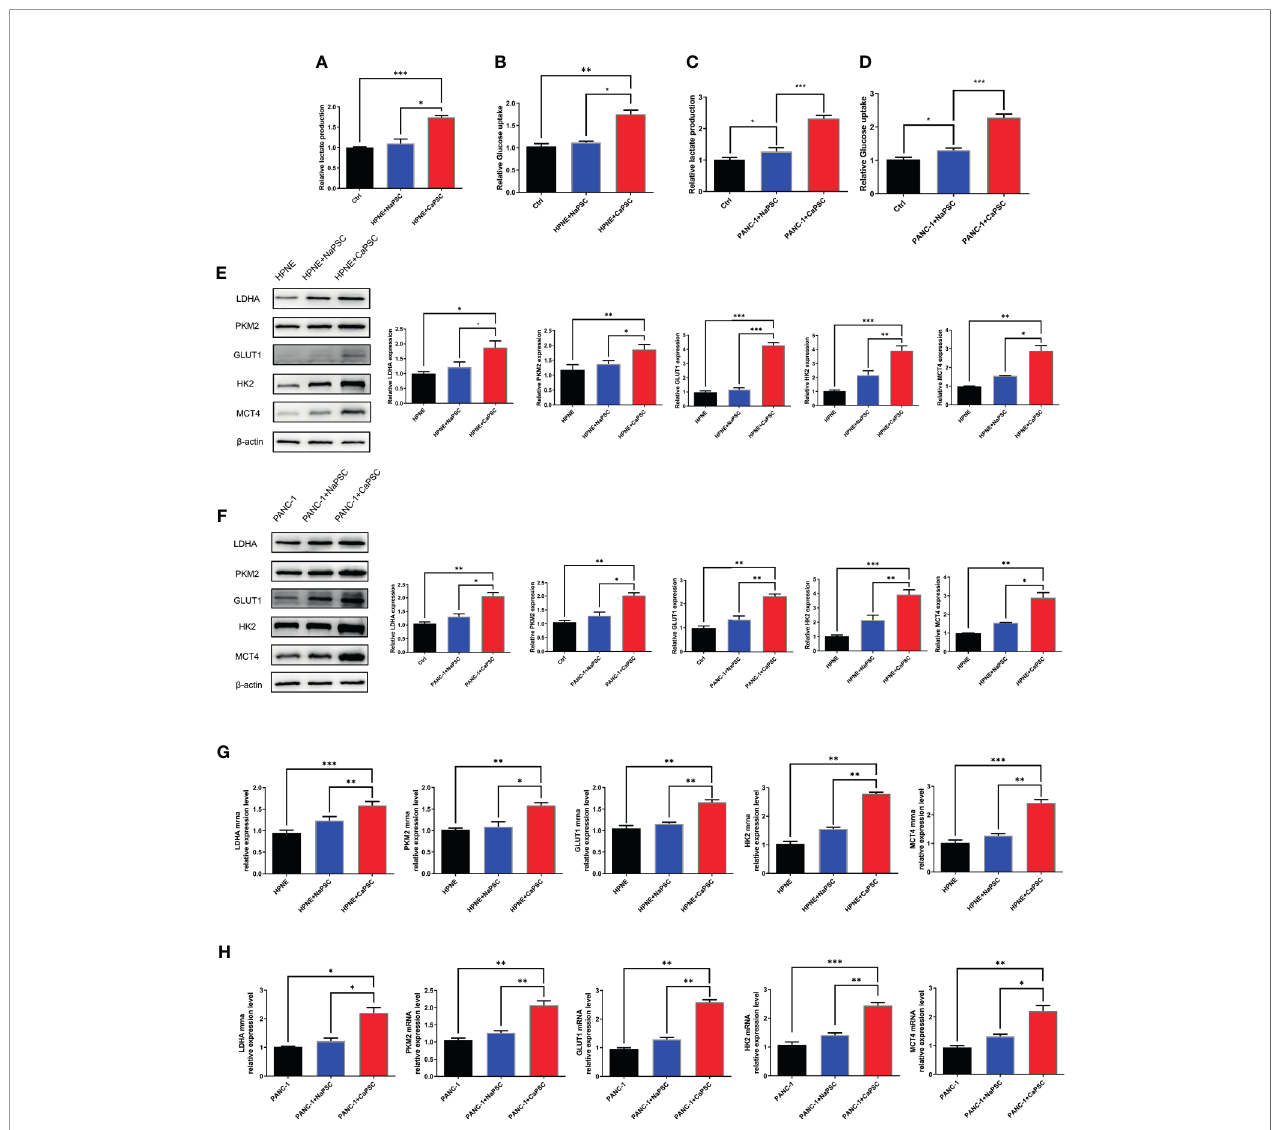
FIGURE 3 | Co-culture with CaPSCs promoted lactic acid production, glucose consumption and the expression of the glycolytic proteins LDHA/PKM2 in HPNE and PANC-1 cells. (A) Changes in HPNE cell lactic acid production after co-culture with NaPSCs or CaPSCs; (B) Changes in HPNE cell glucose consumption after co- culture with NaPSCs or CaPSCs; (C) Changes in PANC-1 cell lactic acid production after co-culture with NaPSCs or CaPSCs; (D) Changes in PANC-1 cell glucose consumption after co-culture with NaPSCs or CaPSCs; (E) , E1-E5; G1-G5: Changes in the protein and mRNA expression of PKM2, LDHA, GLUT1, HK2 and MCT4 in HPNE cells after co-culture with NaPSCs or CaPSCs; (F) , F1-F5; H1-H5: Changes in the protein and mRNA expression of PKM2, LDHA, GLUT1, HK2 and MCT4 in PANC-1 cells after co-culture with NaPSCs or CaPSCs; *P < 0.05, **P < 0.01, ***P <